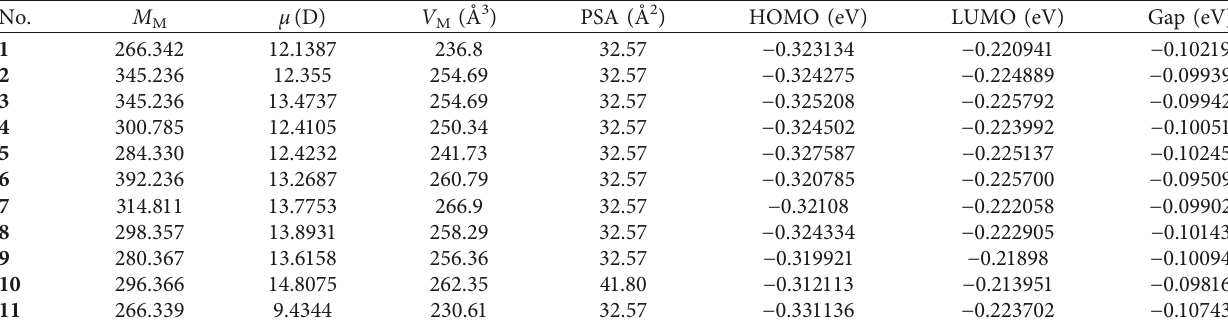
Table 5: Values of physicochemical properties for derivatives 1 – 11 .